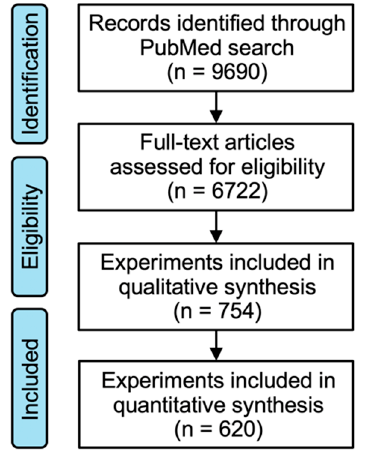
Figure 6. Scheme for the literature search.